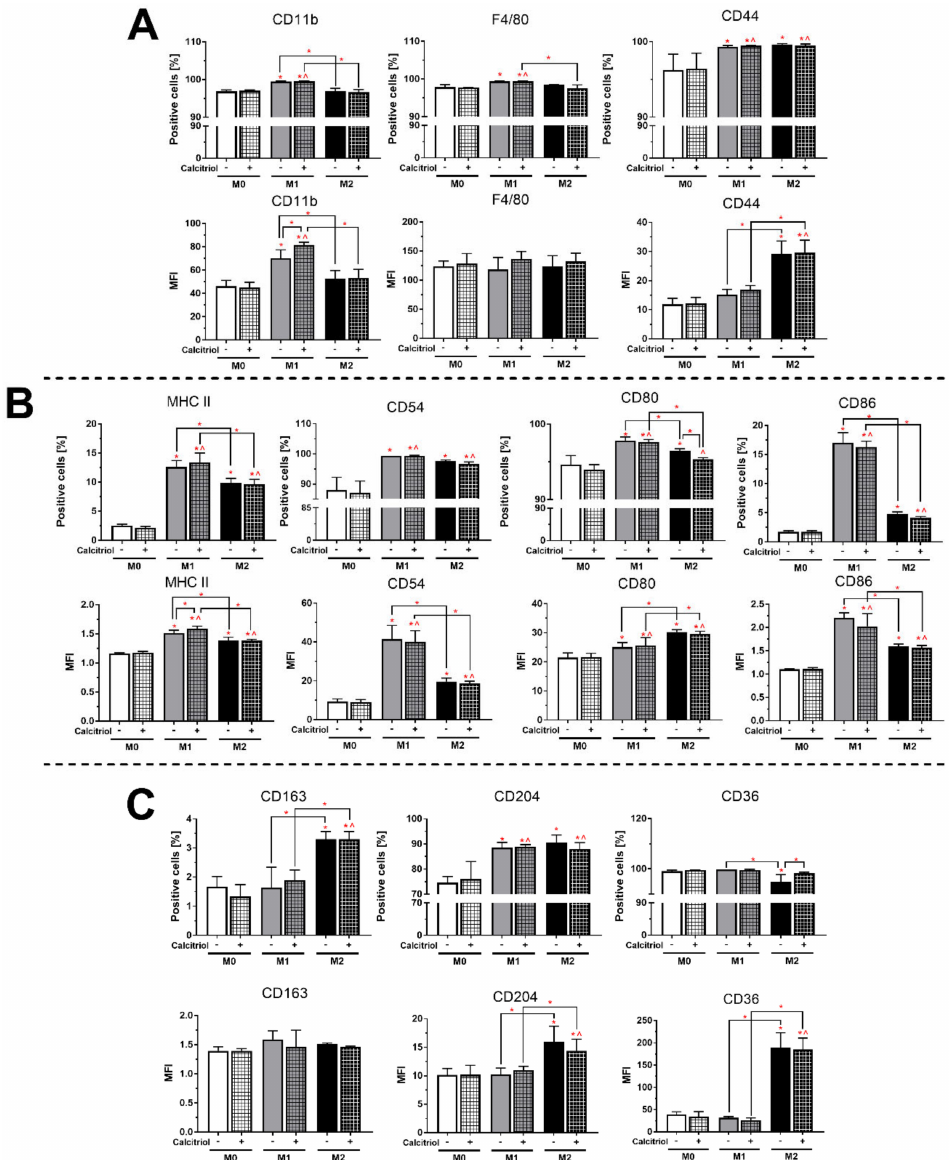
Figure 2. The e ff ect of calcitriol on the expression of surface markers in individual classes of BMDMs analyzed by FACS: ( A ) Pan-macrophage markers, ( B ) M1 markers, and ( C ) M2 markers. Calcitriol enhances CD11b and MHC II expression for M1 BMDMs and lowers CD80 expression and increases CD36 expression for M2 BMDMs. Briefly, BMDMs were detached with a non-enzymatic solution. Then, 0.1 × 10 5 cells were incubated with anti-mouse CD16 / 32 for blocking non-specific binding of immunoglobulin to the Fc receptors. Next, individual antibodies or isotype controls were applied and Fixable Viability Dye eFluor 780 was applied for viability control. The results are presented as percentage of positive cells expressing the examined molecule and as median fluorescence intensity (MFI). The gating strategy and images of representative histograms for each BMDMs class are provided in Figure S2. Data presentation: mean with standard deviation. Number of independent repetitions = 3 (BMDMs cultures generated from three mice). Statistical analysis: Sidak’s or Dunn’s multiple comparisons test. * p < 0.05 as compared to M0, ˆ p < 0.05 as compared to M0 + cal or as